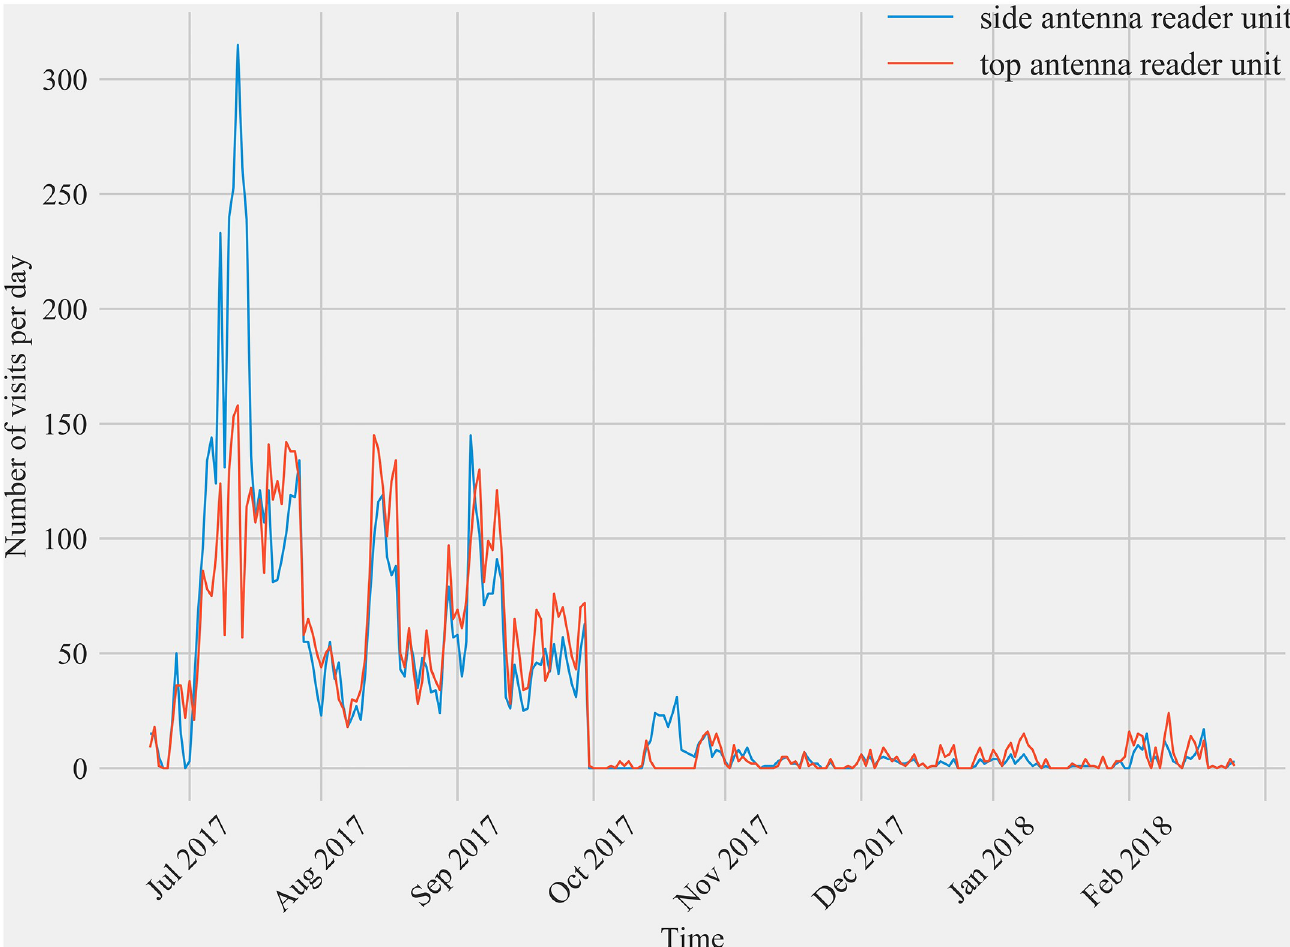
Fig 5. Comparison of the daily detections from the two different antennas at the double antenna feeding station transceiver at Site 2 over time. The top antenna for this feeding station was deployed in May 2017 and discontinued in January 2018 for data collection. Overall, the total number of visits detected by the side antenna exceeded the number of visits for the top antenna but not enough to warrant the addition of a second antenna. Both antennas detected the presence of the same number of individual